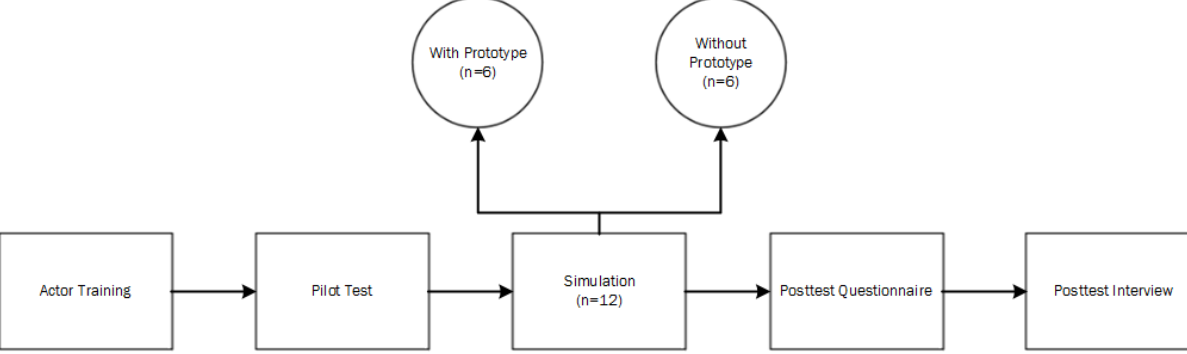
Figure 2. Model of the experimental